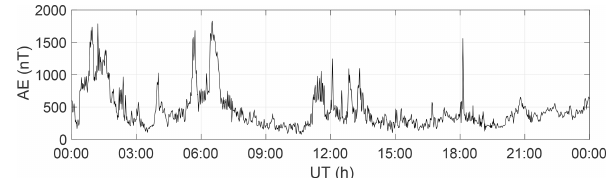
Figure 1. The auroral electrojet index at 1min intervals on 31 Oc- tober 2003.